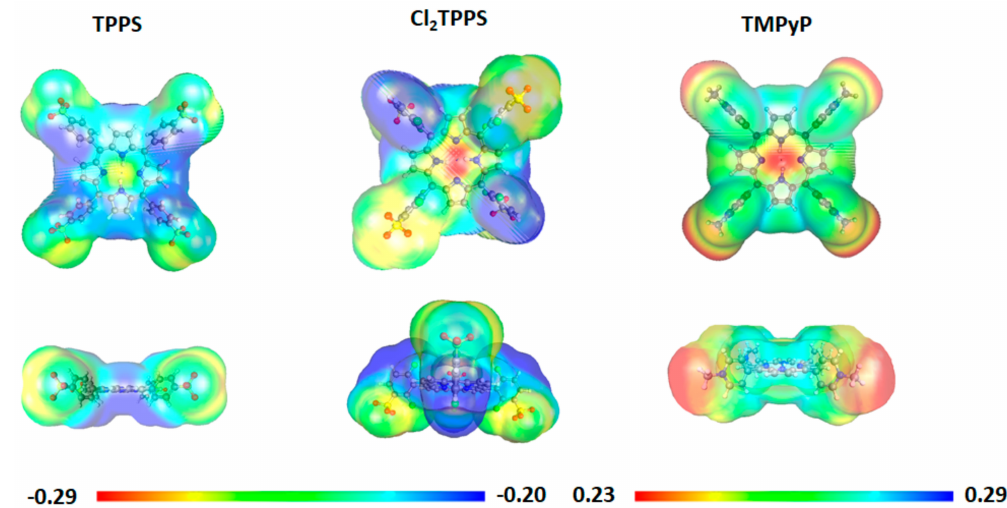
Figure 3. Electronic density maps of the photosensitizers from the total self-consistent field density mappedwiththeelectrostaticpotential, isovalue = 0.0004, attheB3LYP / 6-31G(d)levelintheatomicunits.